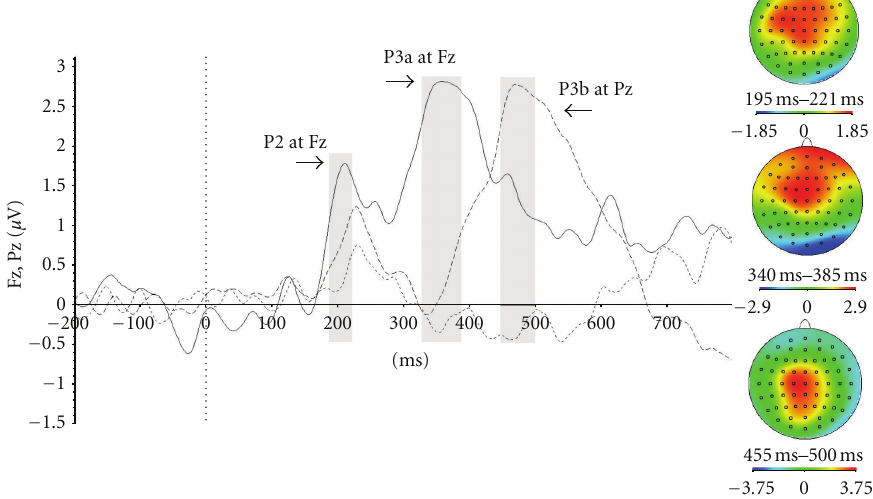
Figure 2: Event-related potentials that isolate the P2, P3a, and P3b components from averages that do not take into account the side of the target stimulus (in target-present trials). We subtracted the average waveform from the frequent-target, frequent colour, condition (the most frequently occurring condition) from the same-colour (no-go) condition; the solid line shows this di ff erence wave at Fz,while the dashed line shows this di ff erence at Pz. The dotted line shows the di ff erence wave computed by subtracting the frequent-target, frequent colour, condition from the infrequent-target-colour condition, at Fz which would have been another way to evoke the P3a, according to classic oddball